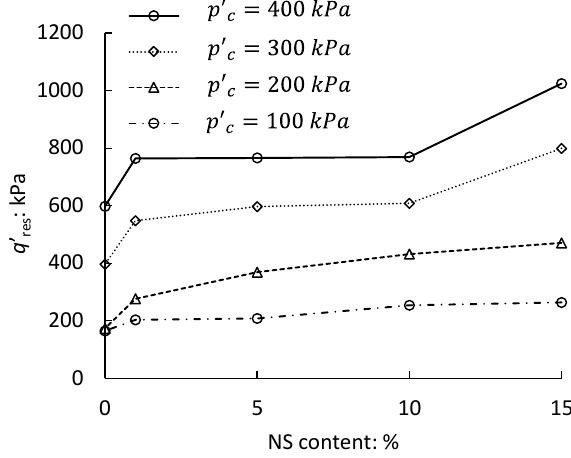
Figure 11. Variation in residual deviatoric stress with nano-silica content.